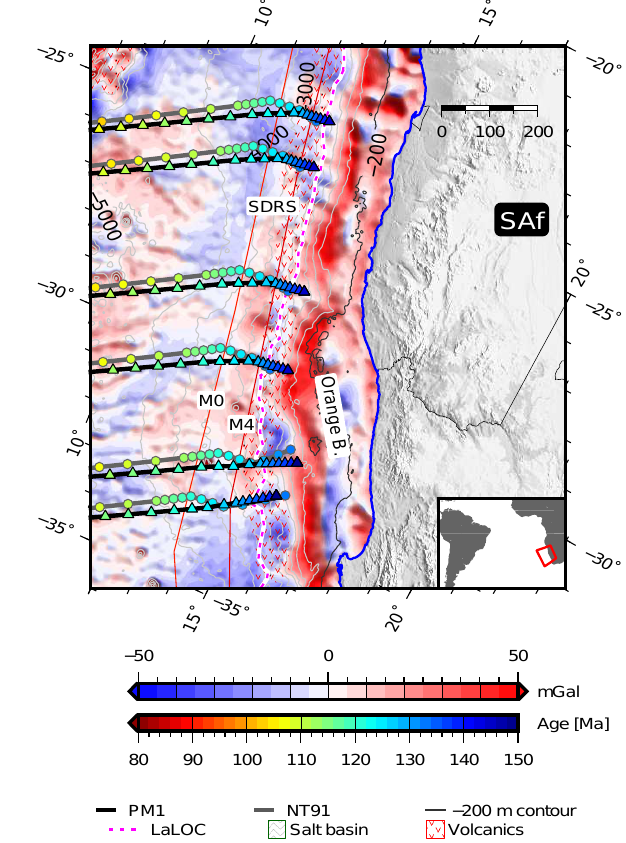
Fig. 11. Age-coded flowlines plotted on filtered free-air gravity basemap (offshore) for the Orange Basin segment along the west African margin. Early phase opening is oblique to present-day mar- gin, with oblique initial extension of SAm relative to SAf (4 north- ern flowlines) in WNW-ESE direction and initial extension between Patagonian South American blocks and SAf in SW–NE direction (southern 2 flowlines). Note that the Orange Basin is located be- tween the two divergent flowline populations and that a positive gravity anomaly is contemporaneous with the inflection point at 126.57Ma (M4) and associated velocity increase and extension di- rection change (cf. Fig. 15) along the margin. Legend/symbology and filter as in Fig.